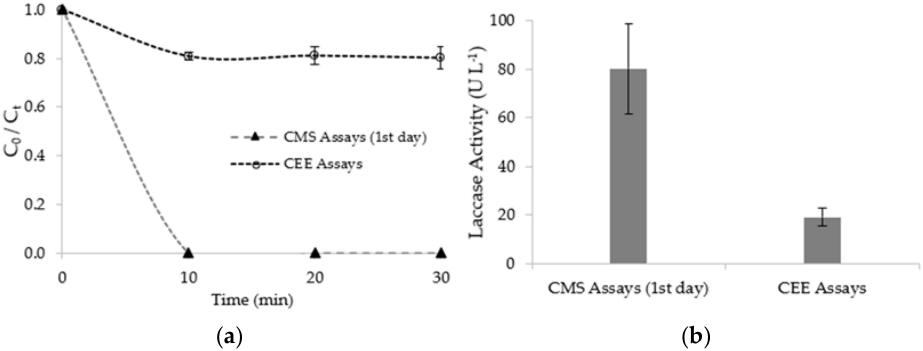
Figure 5. ( a ) Progression curves of residual fluoxetine concentration over time and ( b ) mean laccase activity of the CMS (at the first day) and crude enzyme extracts (CEE) assays.